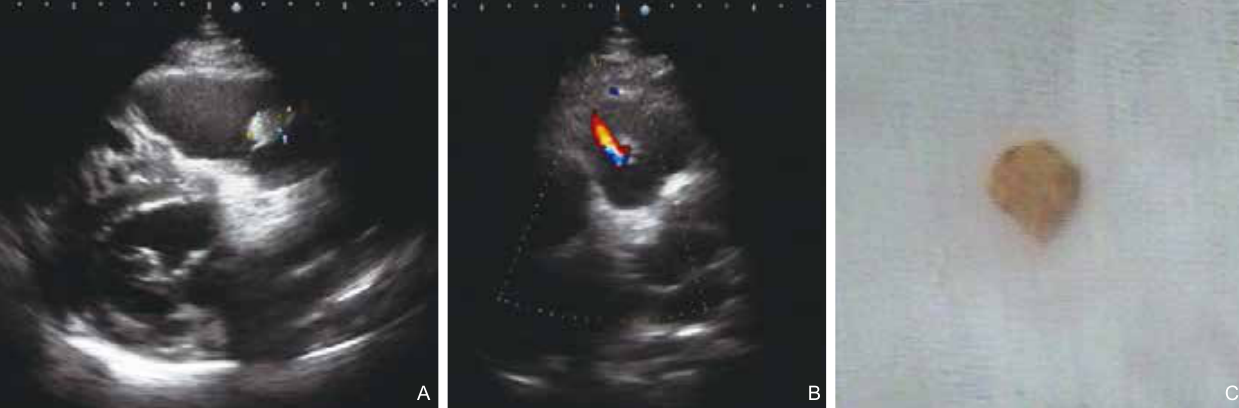
cardiomyopathy; PV, pulmonary